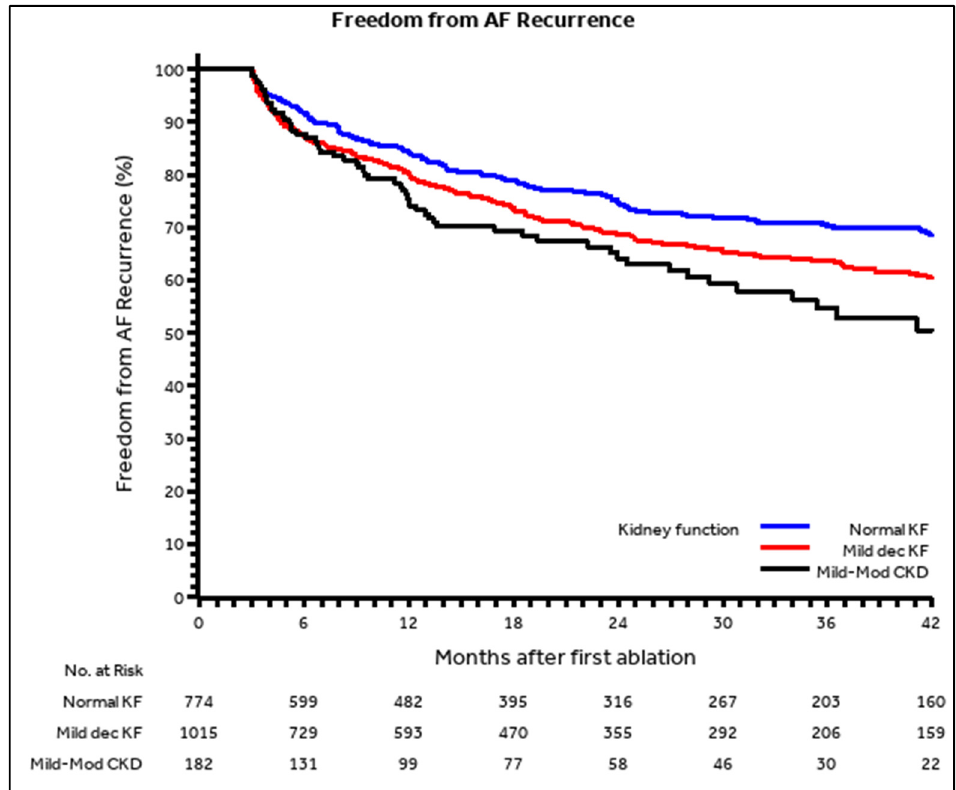
Figure 1. Kaplan–Meier curves. Freedom from AF recurrence according to kidney function. Legend: